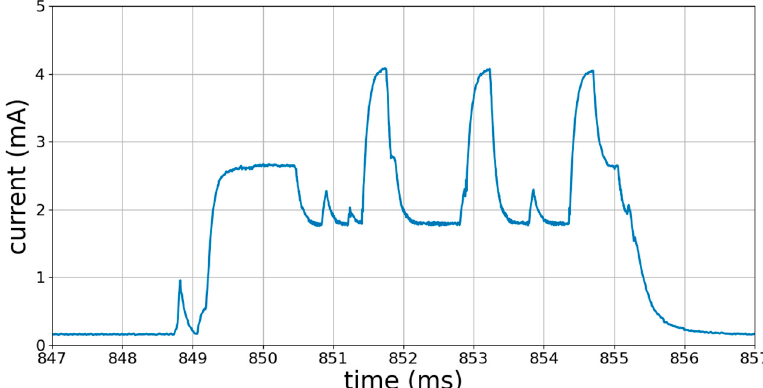
Figure 5. Profile of the power consumption of the BLE device during advertising, i.e., the broadcast of the advertising packet on each of the three primary advertising channels, one after another. Each peak corresponds to the advertising on a channel.